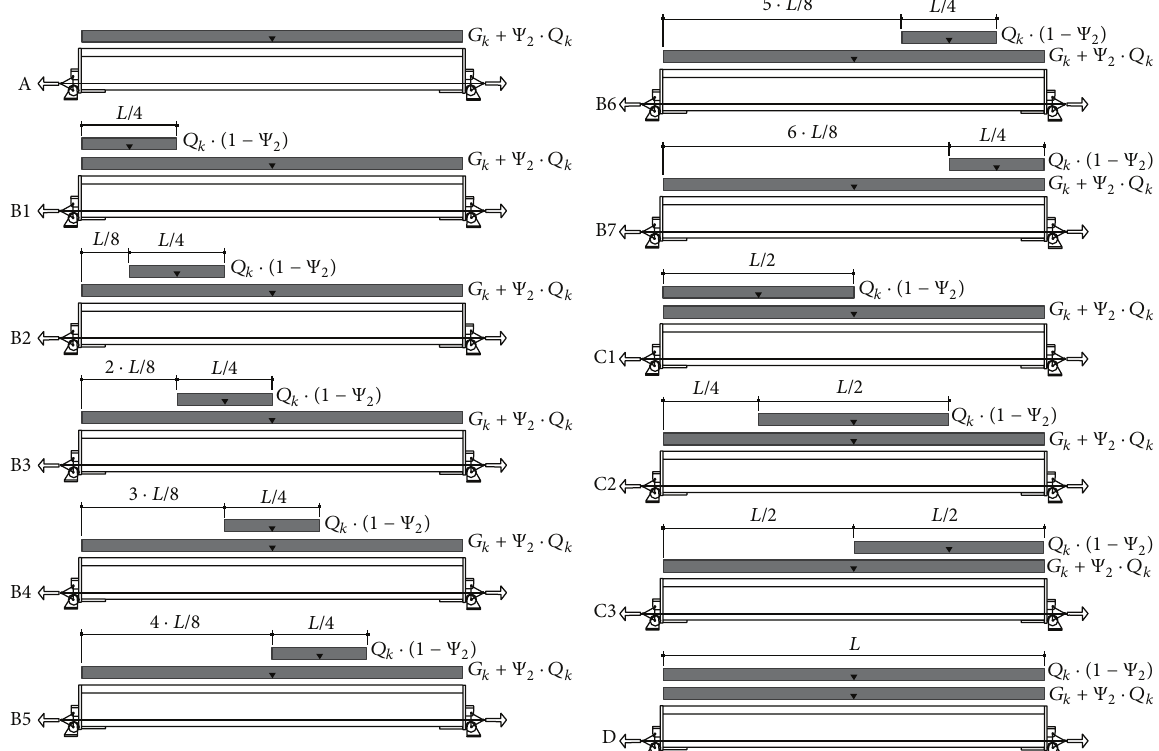
Figure 4: Analyzed load